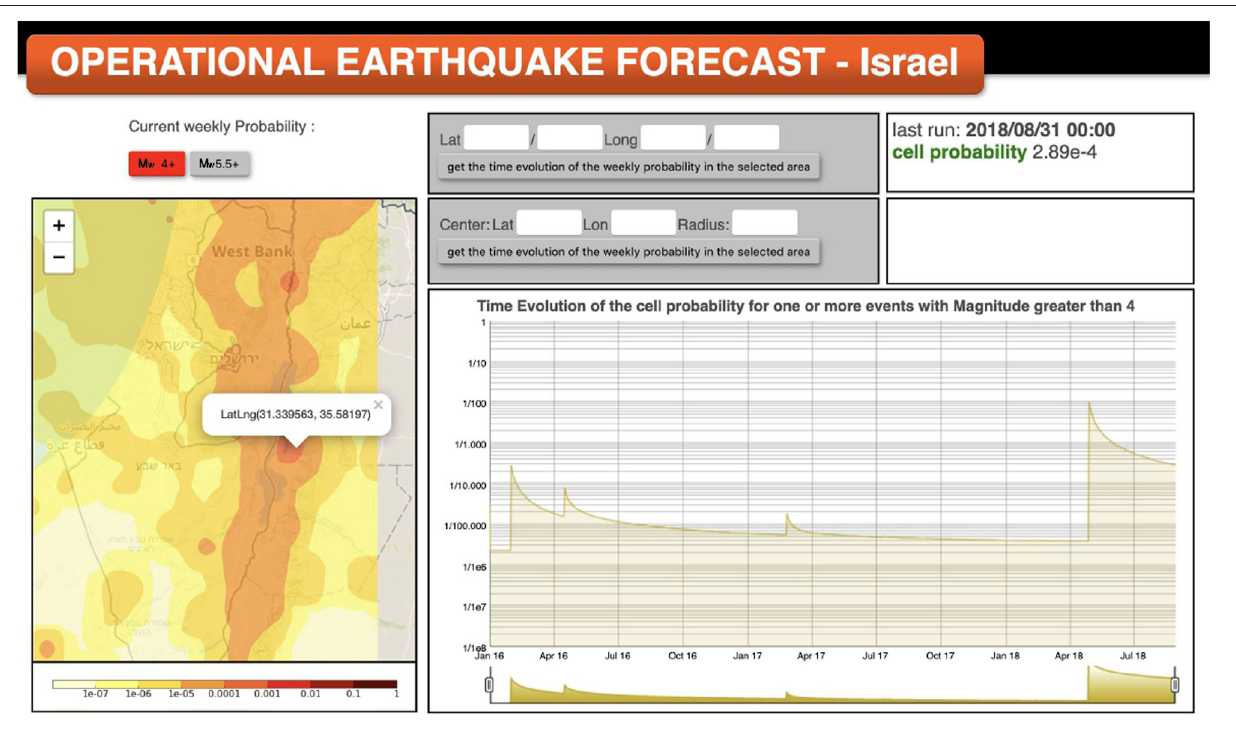
FIGURE 2 | A snapshot of the OEF-Israel forecasting system. The interactive dashboard composed of (left) an embedded Google Maps showing the current weekly probability map for moment magnitude M w ≥ 4 and M w ≥ 5.5. On the lower right, a timeline graph shows the probability history for a cell marked on the map of Israel. The upper right part reports the probabilities of the last run of the